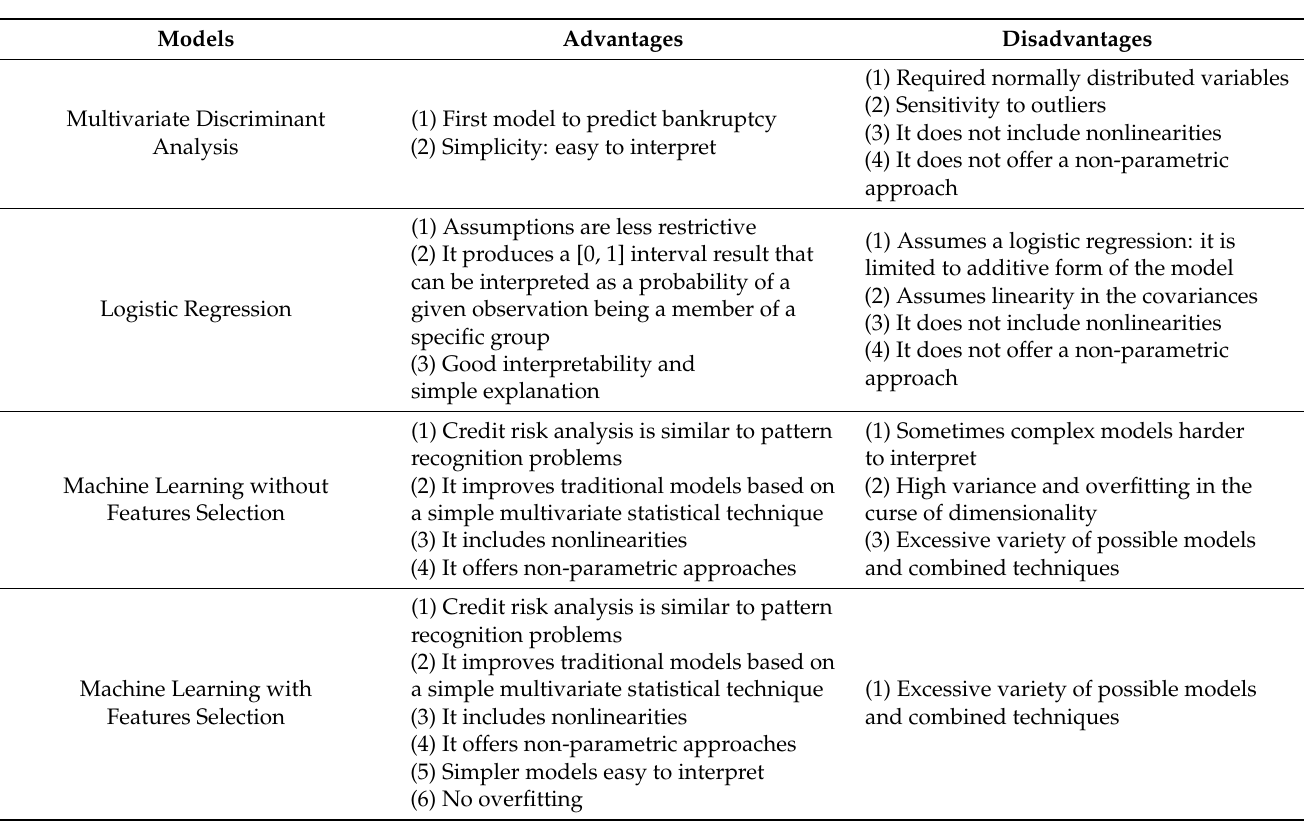
Table 8. Advantages and disadvantages of credit scoring models: form Altman Z-score to machine learning with feature selection